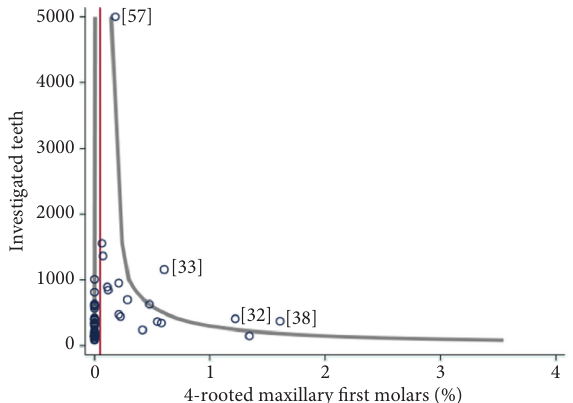
Figure 5: Funnel Plot. The vertical red line marks the median of all studies (0.047). The two gray curves mark the 95% confidence interval, assuming a true percentage of 0.047. The left gray line marks the lower limit of the 95% CI and runs almost parallel to the y -axis; i.e., the lower boundary is 0. Overall, the percentage of teeth with 4 roots is small (0.047%); therefore, a large part of the studies shared